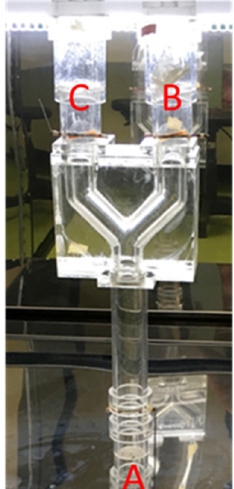
Figure 1. Image of the Y-tube olfactometer.